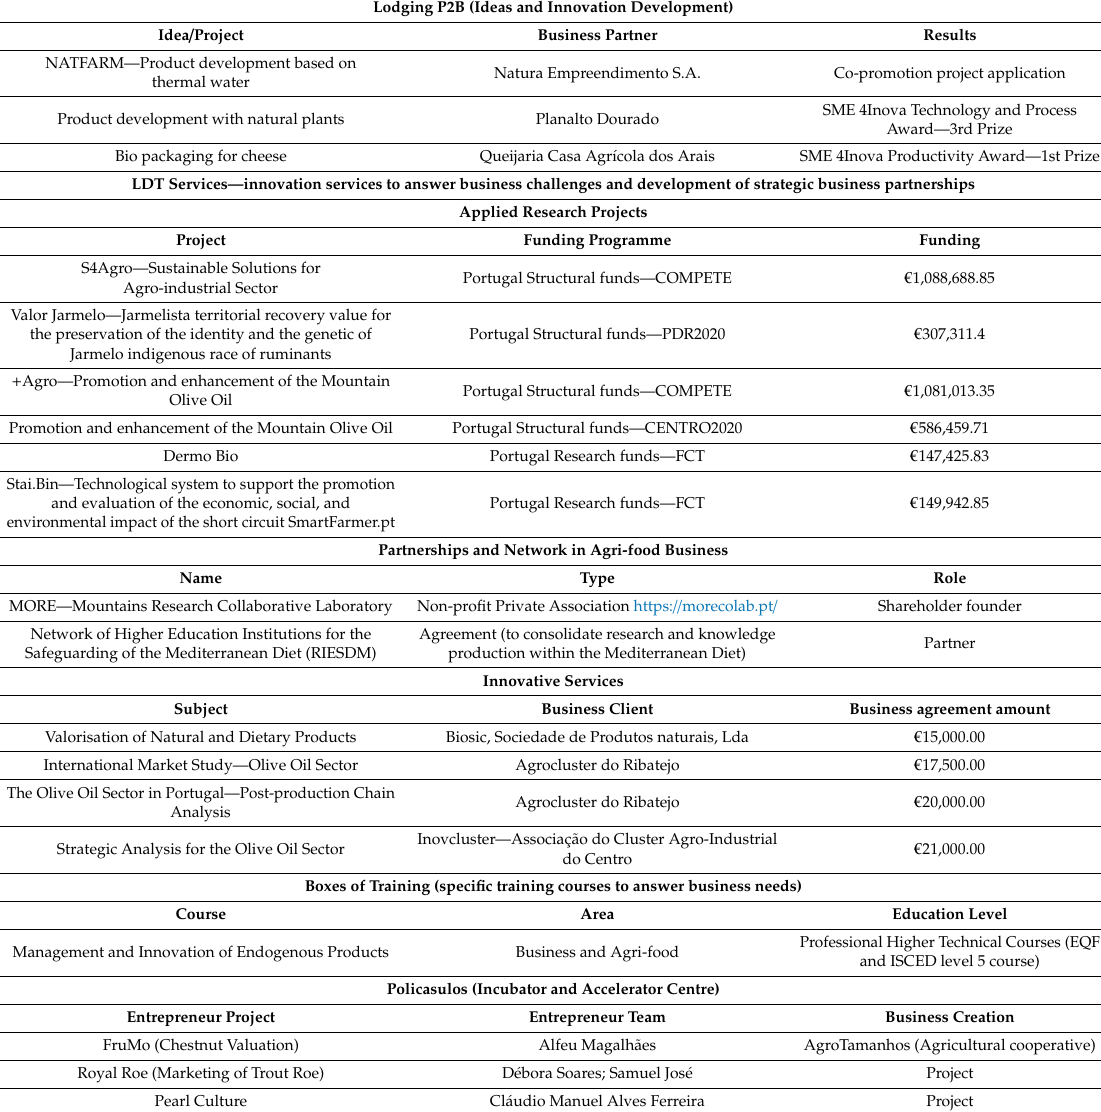
Table 3. Polytechnic to business (P2B) agri-food implementation areas of the last five